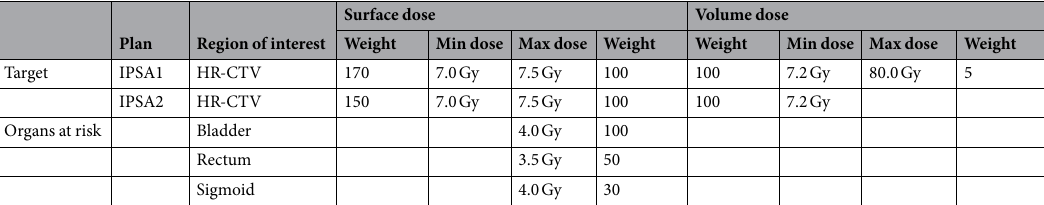
Table 2. Dose objectives and weighting factors used for IPSA